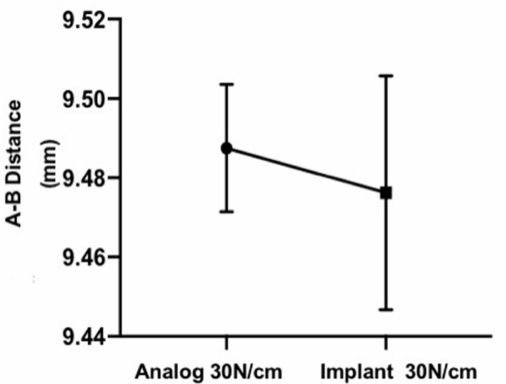
Figure 6. Chart showing the similarity between the distance A–B when the 30 N torque is applied to the analog and the